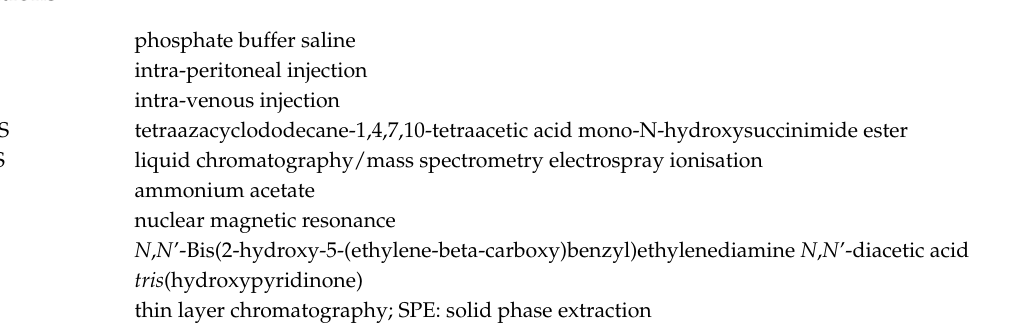
preparations, Figure S1: ESI-LC-MS analysis of DOTA-C21,Figure S2: 1 H-NMR spectra of DOTA-C21 in D 2 O and in MeOD- d 4 at 25 ◦ C, Figure S3: 13 C-NMR spectra of DOTA-C21 in MeOD- d 4 at 25 ◦ C, Figure S4: ESI-LC/MS analysis of Ga-DOTA-C21, Figure S5: Detailed ESI-LC/MS of one Ga-DOTA-C21 isomer, Figure S6: 1 H-NMR titration of DOTA-C21 with Ga 3+ , Figure S7: Aliphatic region of 1 H-, 1 H-COSY-NMR spectrum of Ga-DOTA-C21 in MeOD- d 4 at 25 ◦ C ([DOTA-C21] = 0.63 mM), Figure S8: LC/MS fragmentation experiments on curcumin, Figure S9: UV–vis absorption spectra of the system Ga 3+ /DOTA-C21, Figure S10: Fluorescence emission spectra of the system Ga 3 + /DOTA-C21,Figure S11: TLC analyses of 68 Ga-DOTA-C21 prepared by using the post processing method, Figure S12: Average biodistribution of 68 Ga-DOTA-C21 extracted from micro-PET data at various time points post i.p. and i.v. injection. Correlation between T/M ratio and tumour size, Figure S13: In vivo stability of 68 Ga-DOTA-C21 in murine blood